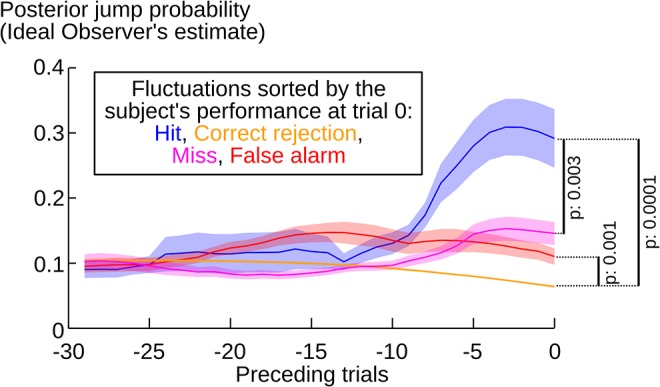
Accuracy of the subjects' jump detections.Subjects’ jump detections followed the fluctuations in jump likelihood provided by the sequence of stimuli. Each trial was sorted into four categories (hit, miss, correct rejection and false alarm), based on the comparison between the subjective jump detection and the actual position of jumps in the sequence. This sorting was used as a reference (trial 0) to examine the fluctuations in the posterior jump probability estimated by the Ideal Observer over the preceding trials. P-values correspond to two-tailed paired t-tests at trial 0. Solid lines and error shadings correspond to mean ± sem over subjects.